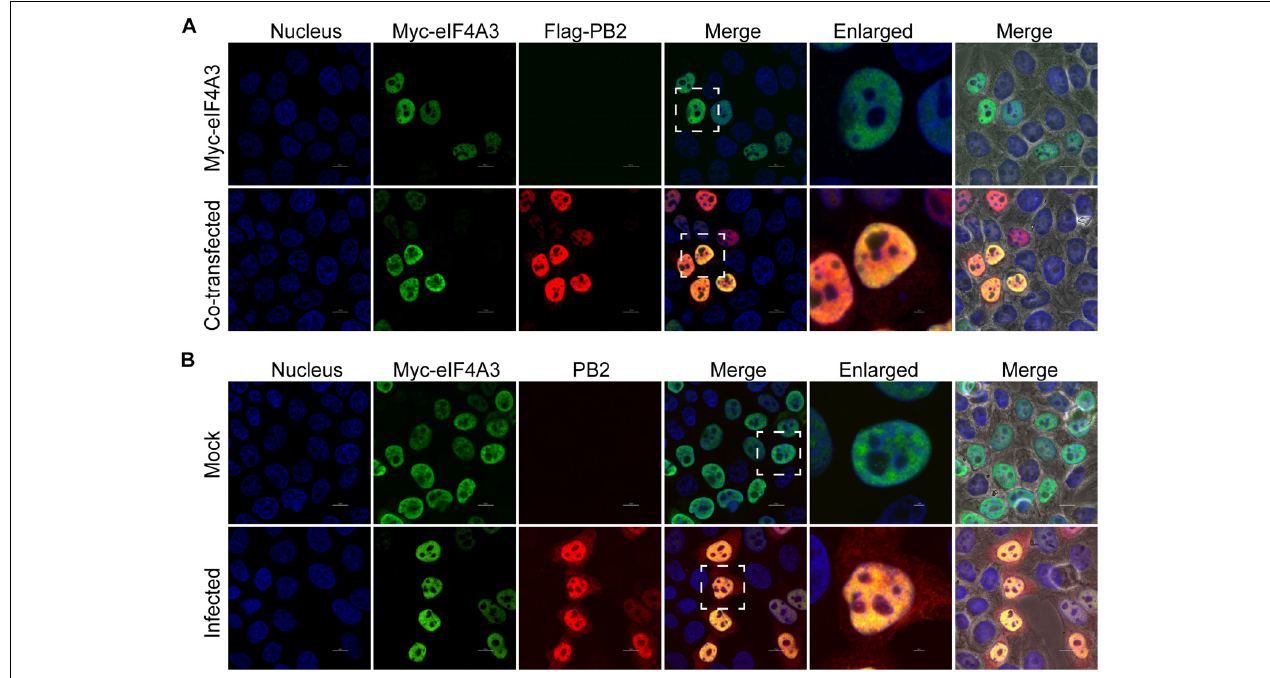
FIGURE 3 | Subnuclear localization of eIF4A3 and PB2. (A) Colocalization of eIF4A3 and AIV PB2 in transfected cells. HeLa cells were co-transfected with Myc-tagged eIF4A3 and Flag-tagged PB2 or Flag-tagged empty vector. After 24 h post-transfection, co-transfected cells were fixed and stained for Myc-tagged eIF4A3 (green) and Flag-tagged PB2 (red) using the anti-Myc mouse antibodies and anti-Flag rabbit antibodies, followed by immunostaining with the secondary antibodies. (B) Colocalization of eIF4A3 and AIV PB2 in infected cells. HeLa cells were transfected with Myc-tagged eIF4A3. After 24 h post-transfection, cells were infected with V virus at an MOI of 1 or mock infected and fixed after 12 h post-infection, then stained for Myc-tagged eIF4A3 (green) and PB2 (red) using the anti-Myc mouse antibodies and anti-PB2 rabbit antibodies, followed by immunostaining with the secondary antibodies. Nuclei were stained with DNA-binding dye DAPI